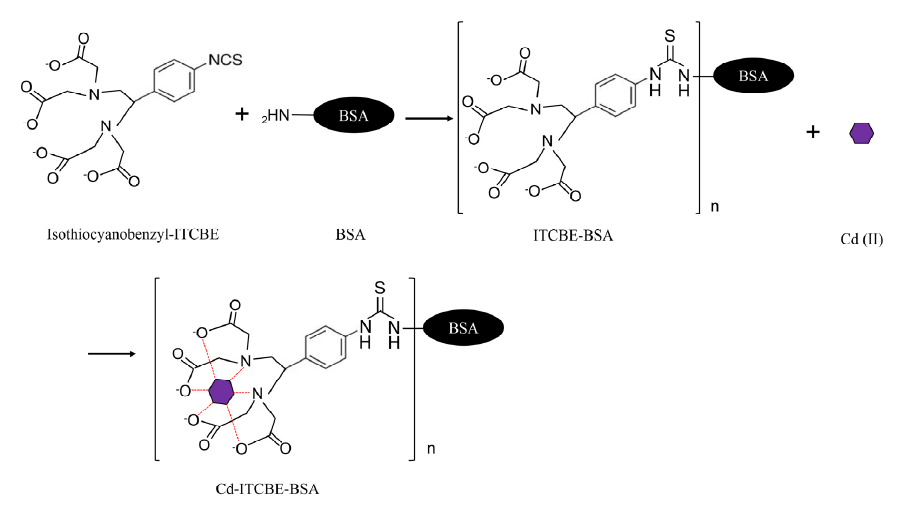
Figure 1. Synthesis scheme of Cd (II) artificial